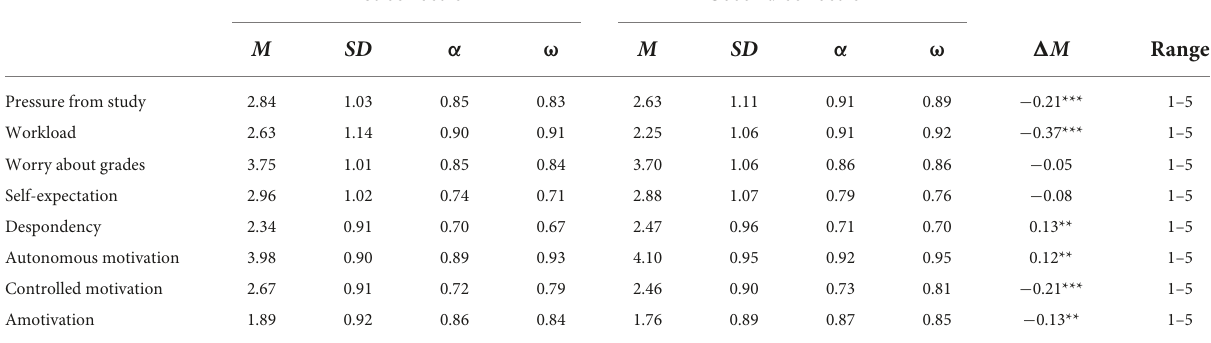
TABLE 2 Descriptive statistics and internal consistency coefficients.